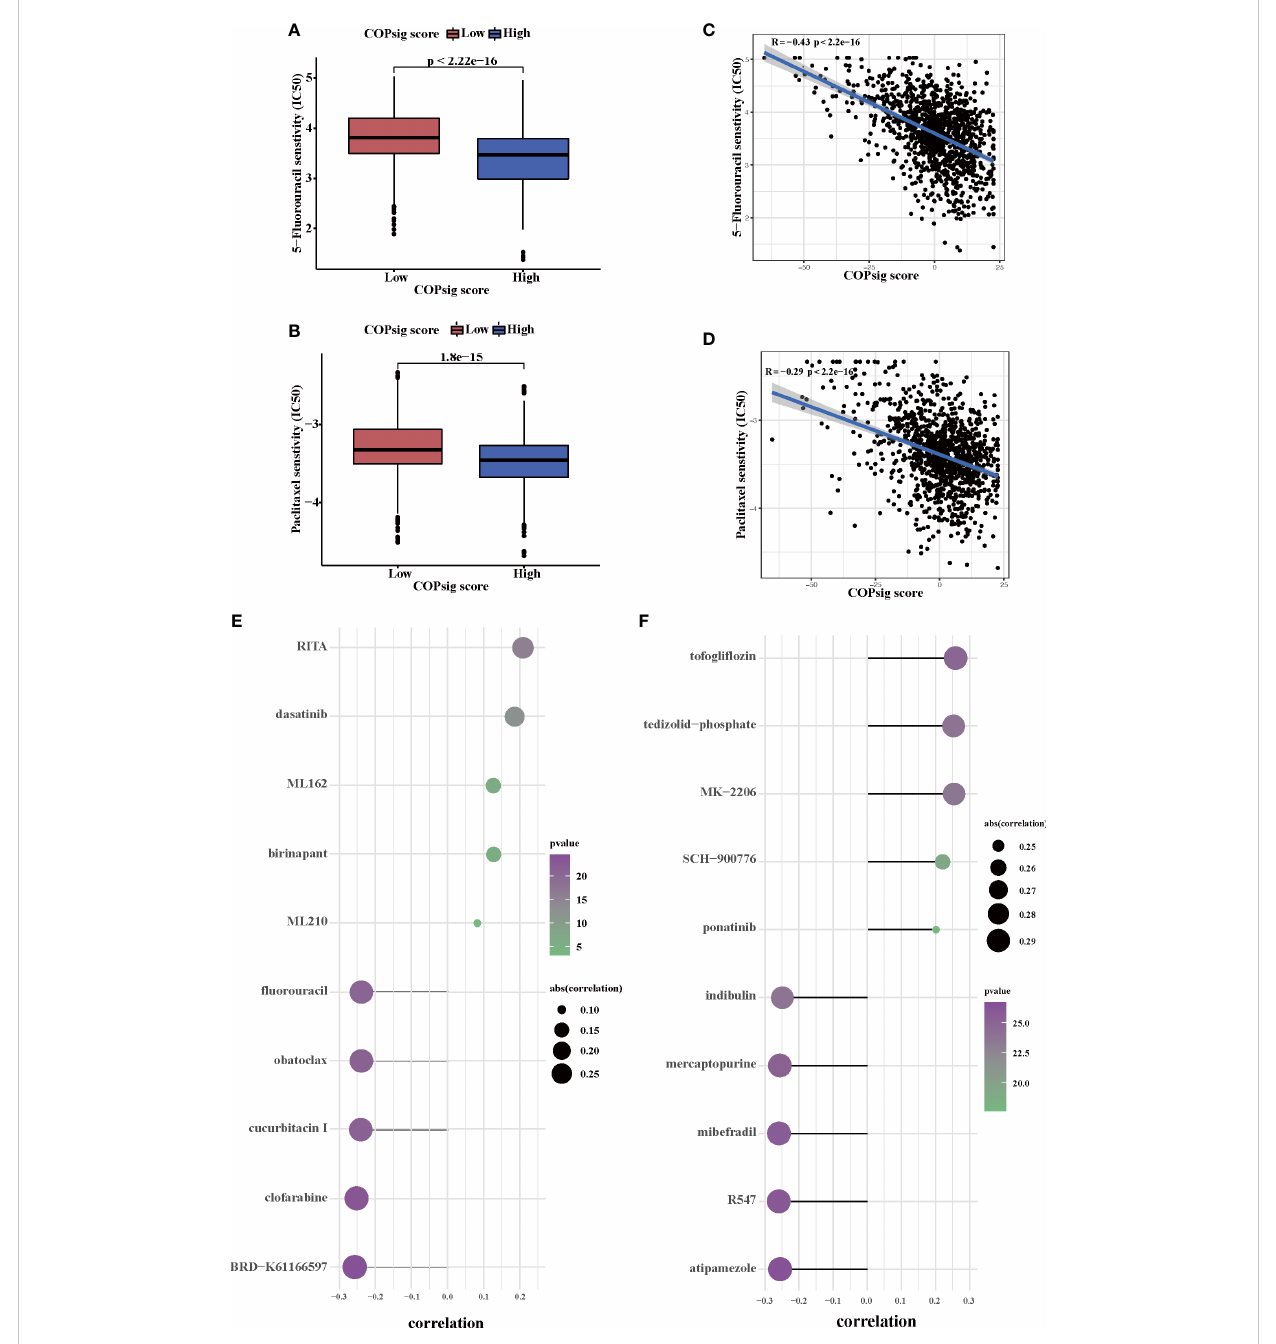
FIGURE 7 Chemotherapy response in the high and low COPsig score groups. (A, B) The differences of response to 5-FU (E) and paclitaxel (F) between the high and low COPsig score groups. (C, D) The correlation between COPsig scores of patients and the estimated IC 50 value of 5-FU (C) and paclitaxel (D) . (E) The results of Spearman ’ s correlation analysis of 10 CTRP-derived compounds. (F) The results of Spearman ’ s correlation analysis of 10 PRISM- derived